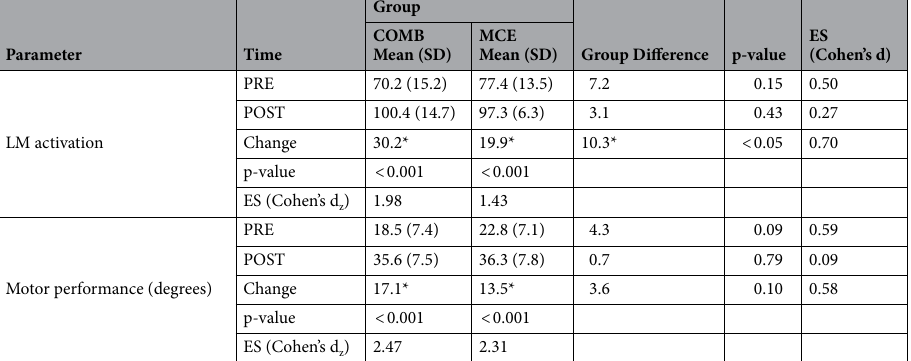
Table 2. Lumbar multifidus muscle activation pairwise between-group comparisons between combined neuromuscular electrical stimulation with motor control exercise group (COMB), and motor control exercise group (MCE), as well as within-group comparison between baseline and post-intervention for each group. *Exceeding 95% confidence minimal detectable